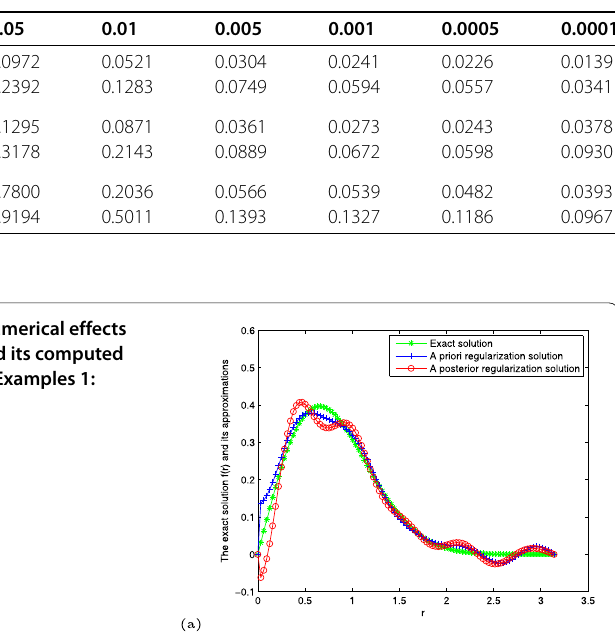
Table 2 Numerical results for different ε under an a posteriori choice rule for three regularization methods about Examples 2